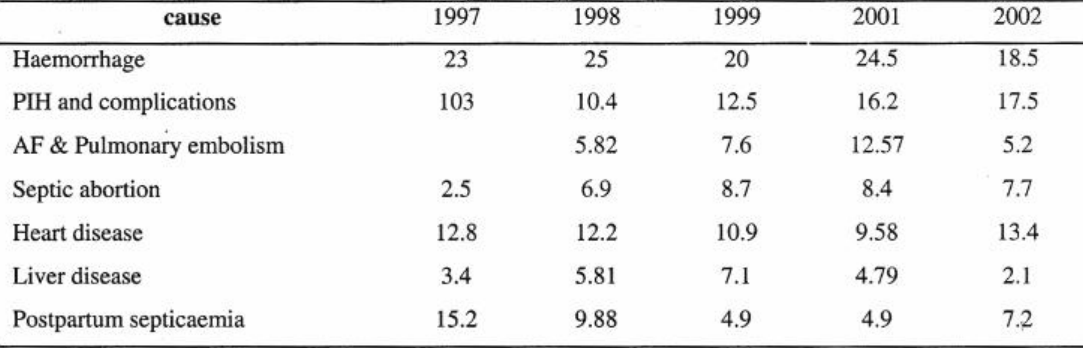
Table 3 - Percentage of Maternal Deaths by Cause in Sri Lanka (1997-2002)